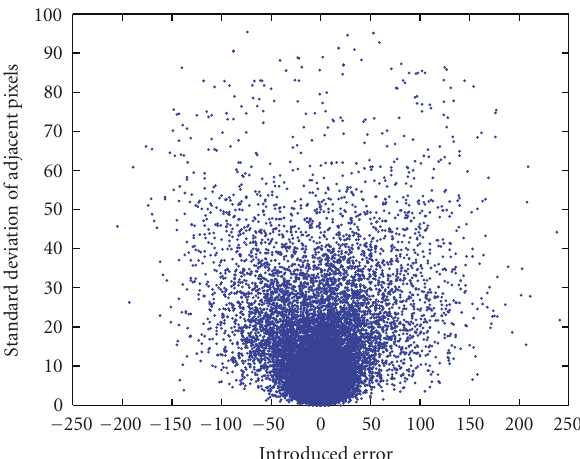
Figure 2: The relation between introduced error and standard deviation of adjacent pixels for Lena.